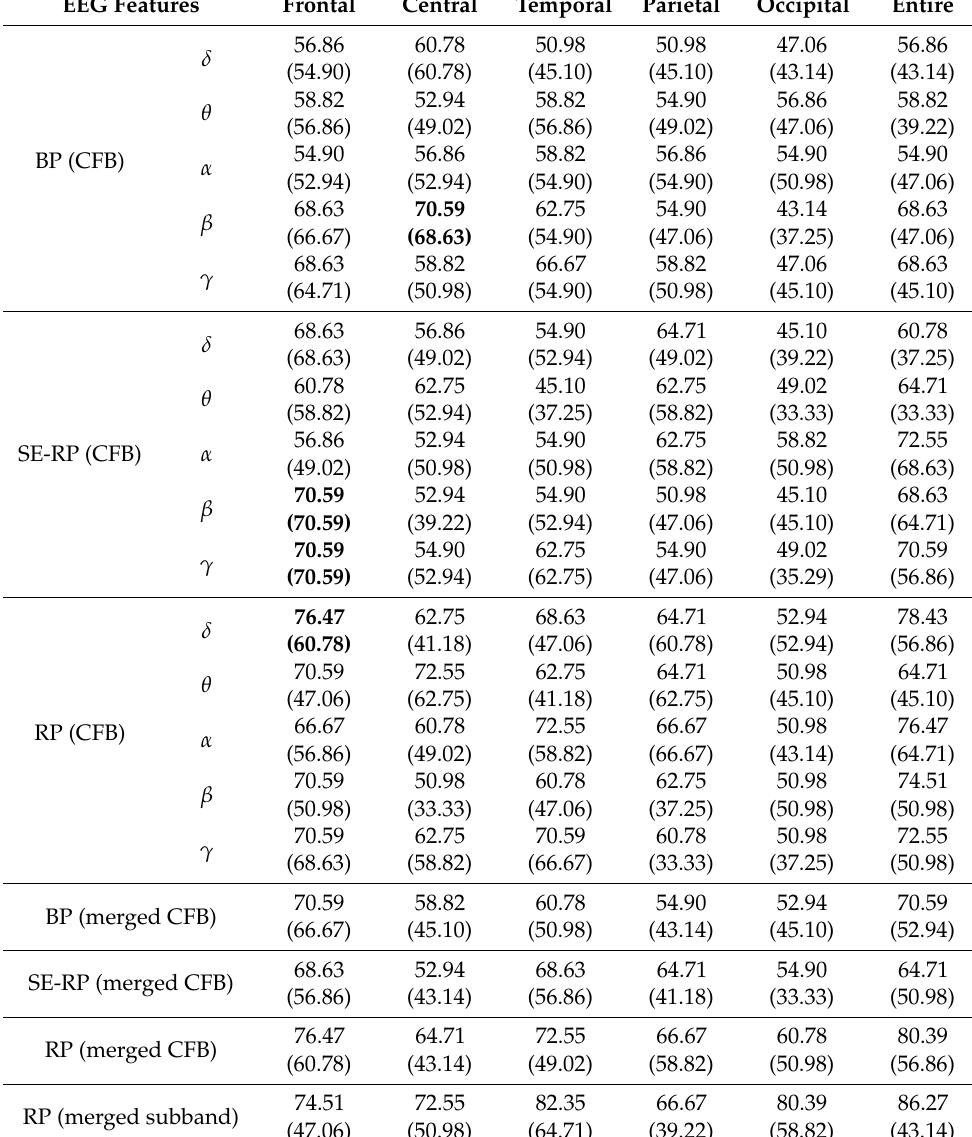
Table 1. Comparison of classification accuracies among different features, frequency bands, and scalp regions using LDA (in %). In each grid of this table, the numbers outside and inside the brackets denote the accuracies obtained from the features with and without feature